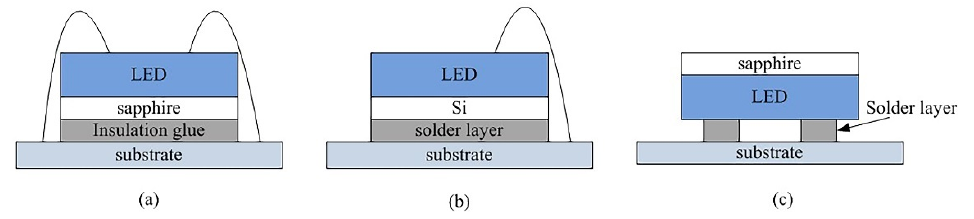
Figure 1. Three high-power LED packaging formats: ( a ) conventional structure, ( b ) vertical LED and ( c ) flip-chip.